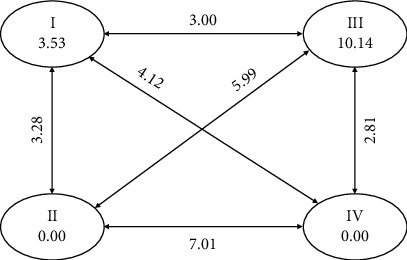
Cluster diagram showing the average intra- and intercluster distances (D=D2 values) of 12 tossa jute genotypes for six anatomical characters contributing to fiber yield.